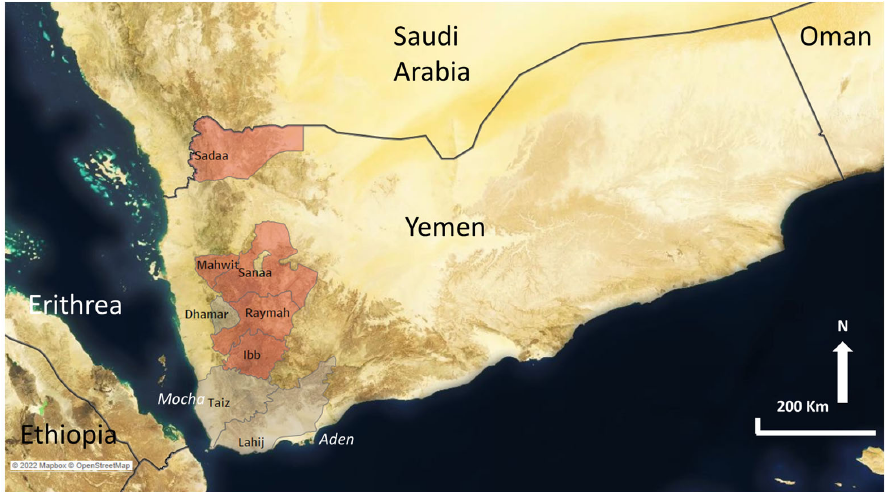
Figure 2. Geographical origin of Yemeni coffee samples included in the study. A total of nine important varieties representing the genetic diversity of cultivated C. arabica around the world [21] were added: Bourbon, Typica, K ‐ 7, Kent, SL ‐ 09, SL ‐ 14, SL ‐ 17, SL ‐ 28 and SL ‐ 34. Finally, four varieties with a clear Ethiopian genetic background [21] were also added: Chiroso, Gesha, Pink Bourbon and SL ‐ 06.